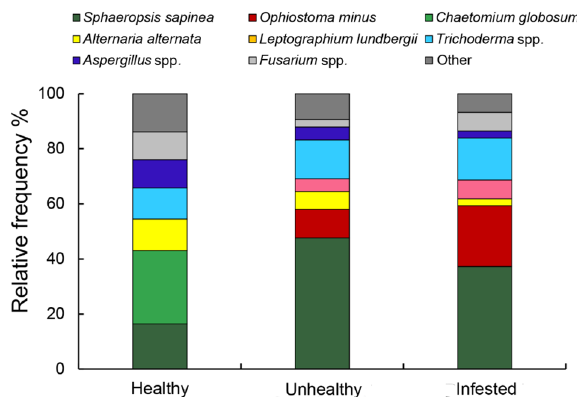
Table 2. Colonization number and significance for forestry of fungal endophytes isolates obtained from three tree samples. *Plant pathogen fungi. a The numbers in the column that assessment of the significance for forestry were references number.